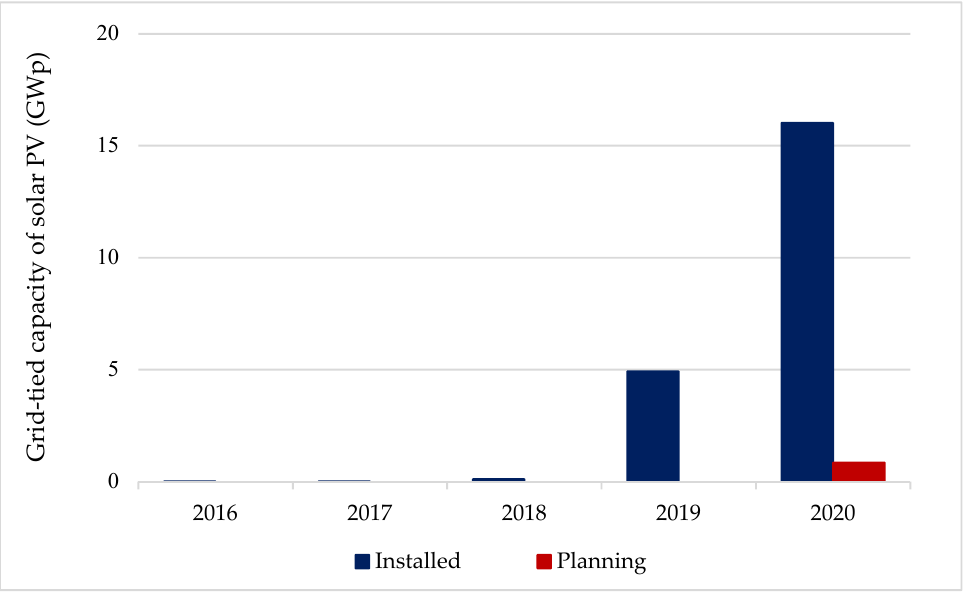
Figure 8. Total installed capacity of Solar PV by 2020 and planning under revised PDP7. Reprinted (Adapted with permission from Refs. [2–4]. Copyright 2020/2021 REN21 Secretariat; 2020 Energies